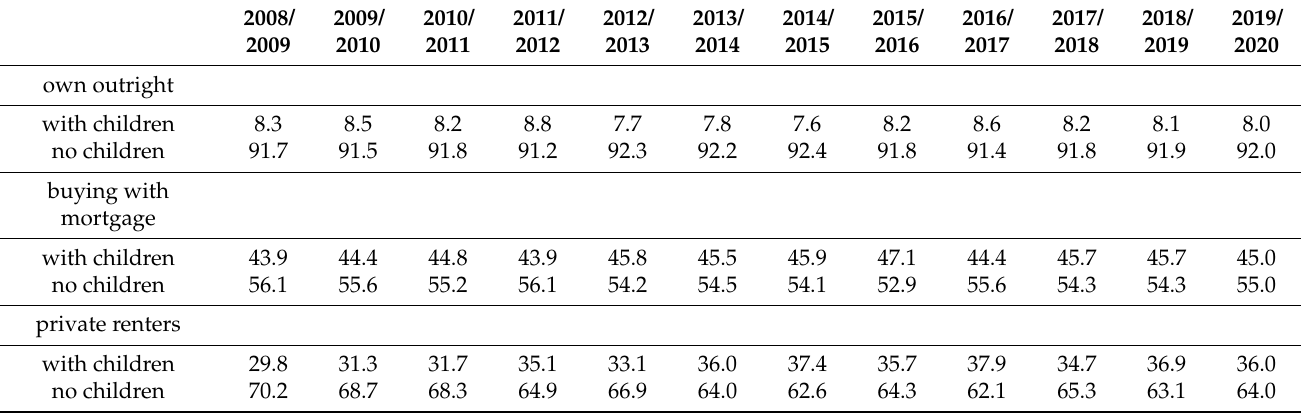
Table A4. Households with dependent children, by tenure, 2003–2004 to 2019–2020